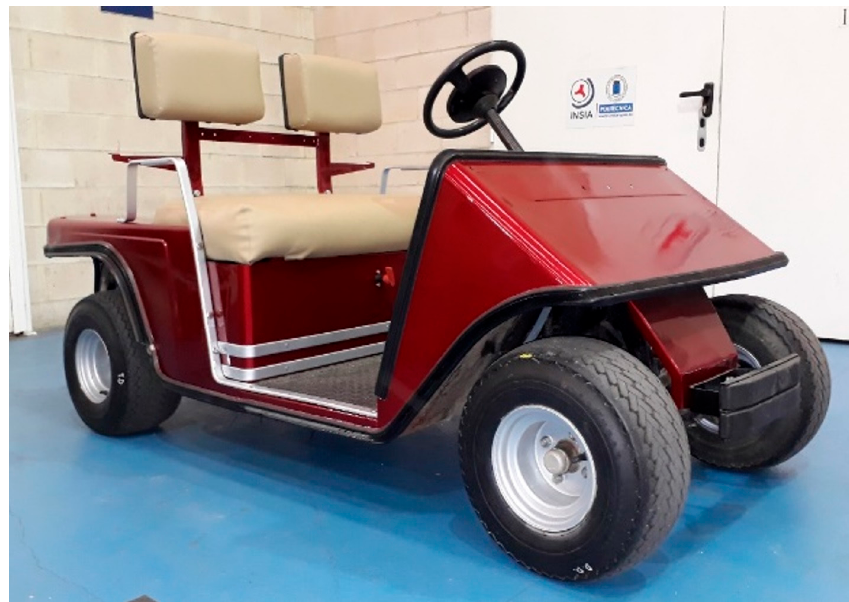
Figure 21. Fuel Cell Extend Range Electric Golf Car.